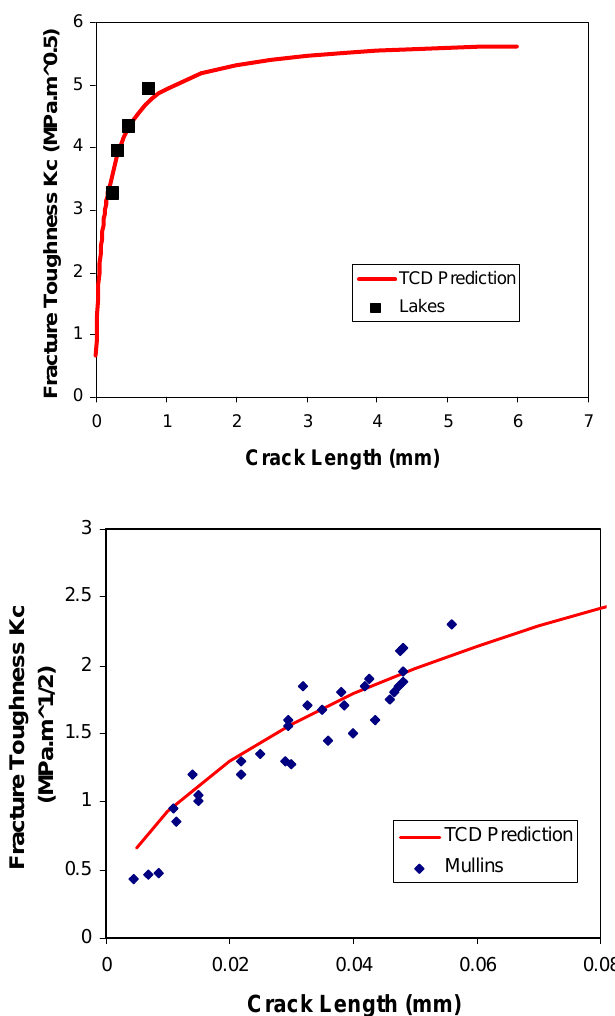
Figure 2: Two sets of data showing the variation of measured fracture toughness as a function of crack length for bone along with TCD predictions. For more details see